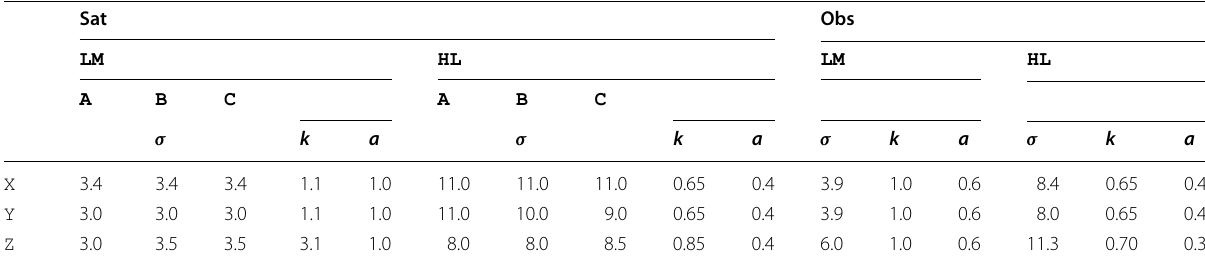
Sat and Obs stand for satellite and observatory data, LM indicates the low- and mid-latitude subset and HL the high-latitude subset (see "Satellite data selection" section). Parameters k and a refer to the applied modified Huber norm for the X , Y and Z component data (Eq. 11). The standard deviations σ (in nT) for the satellite data are given separately for Swarm satellites A , B and